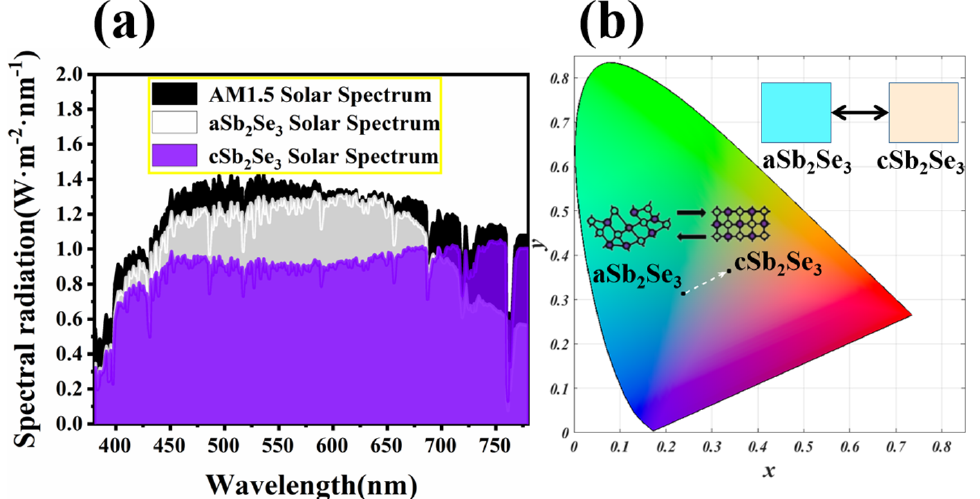
Figure 4. ( a ) Solar spectra under AM1.5, amorphous and crystalline states; ( b ) coordinates on the chromaticity diagram of the aSb 2 Se 3 and cSb 2 Se 3 states with their corresponding displayed colors.